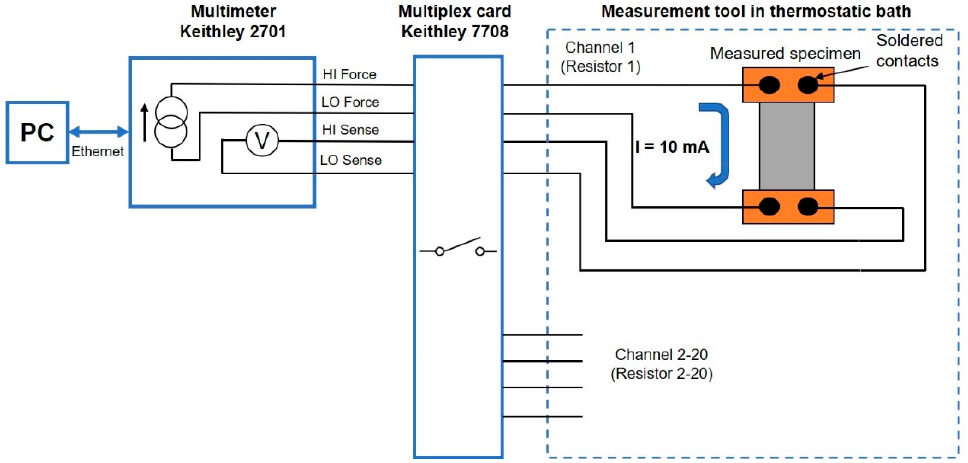
Figure 3. Block diagram of four-wire measurement.